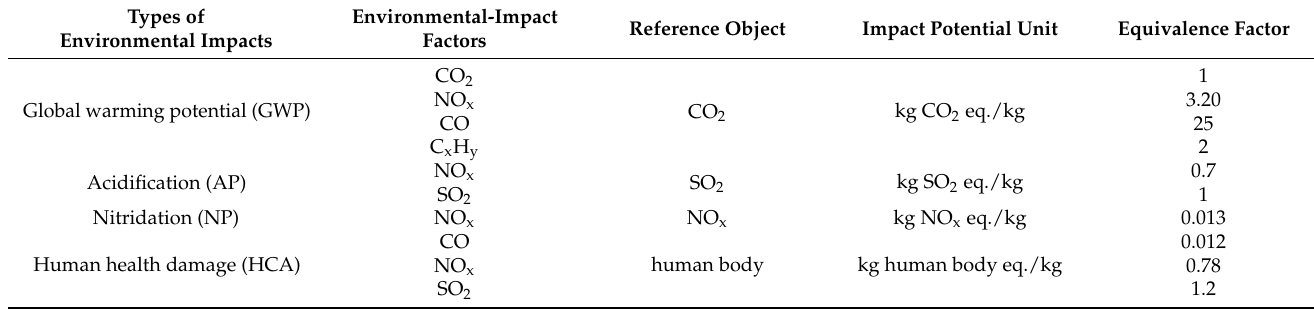
Table 6. Environmental-impact classification and equivalent number.